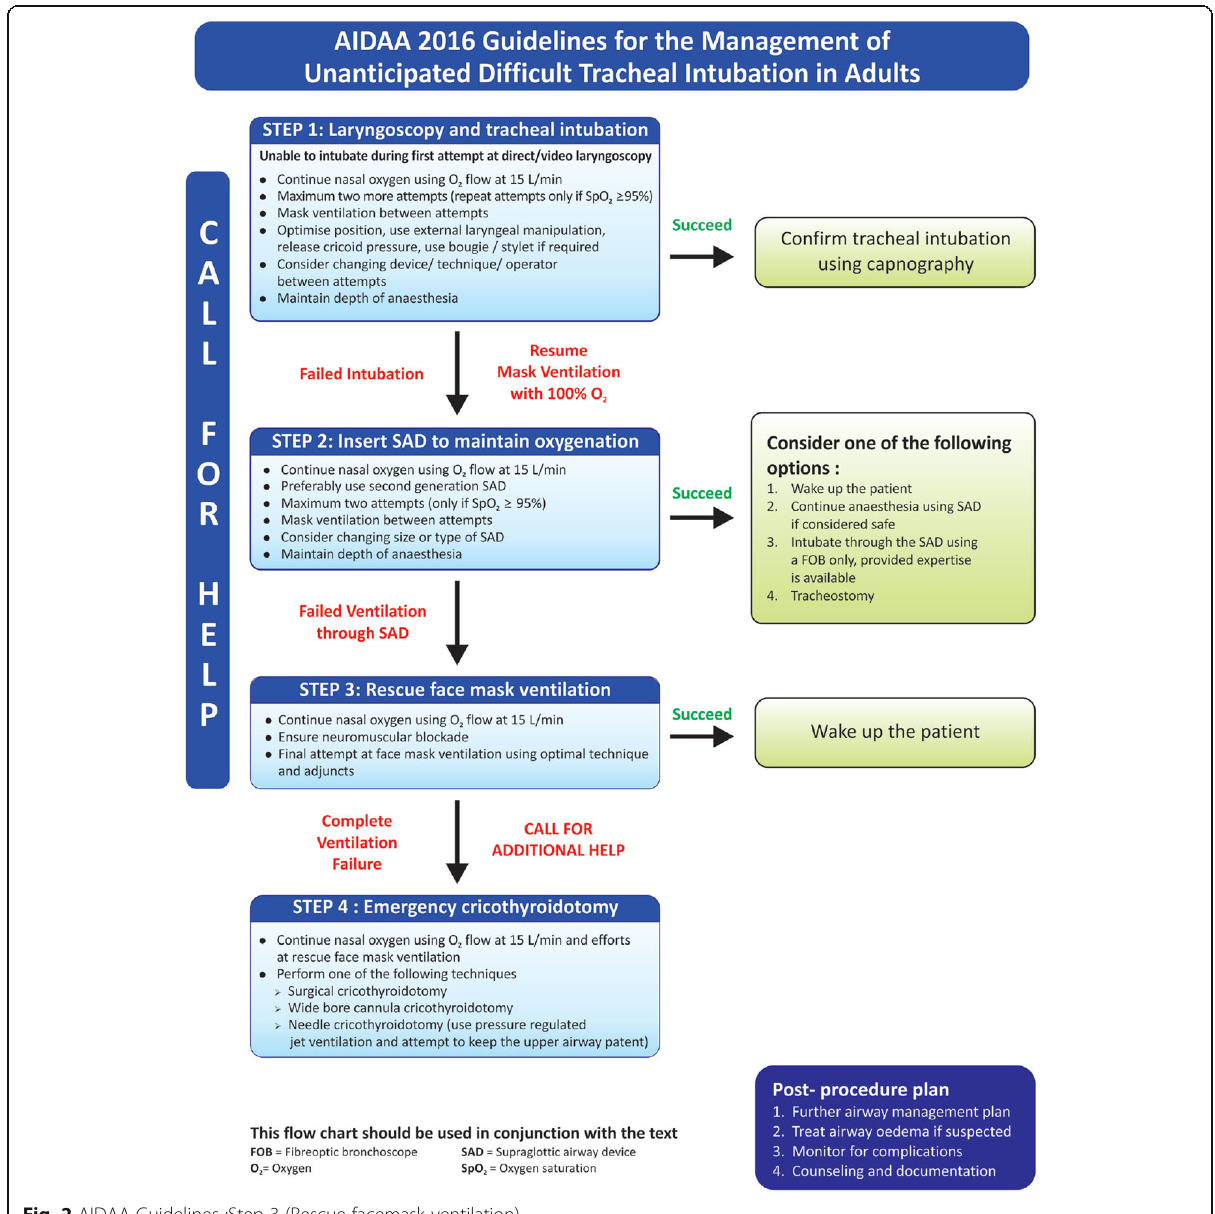
Fig. 2 AIDAA Guidelines :Step 3 (Rescue facemask